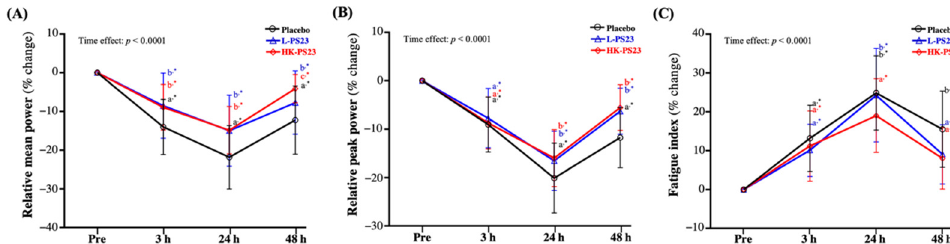
Figure 4. Effect of 6 weeks of L-PS23 and HK-PS23 supplementation on percentage change in Wingate test ( A ) relative mean power, ( B ) relative peak power, and ( C ) fatigue index. Data are expressed as mean ± SD for n = 35 subjects per group. Different superscript letters (a, b, c) indicate a significant difference between groups at the same time point ( p < 0.05). * indicates that each group is significantly different from pre-EIMD at different time points ( p < 0.05).